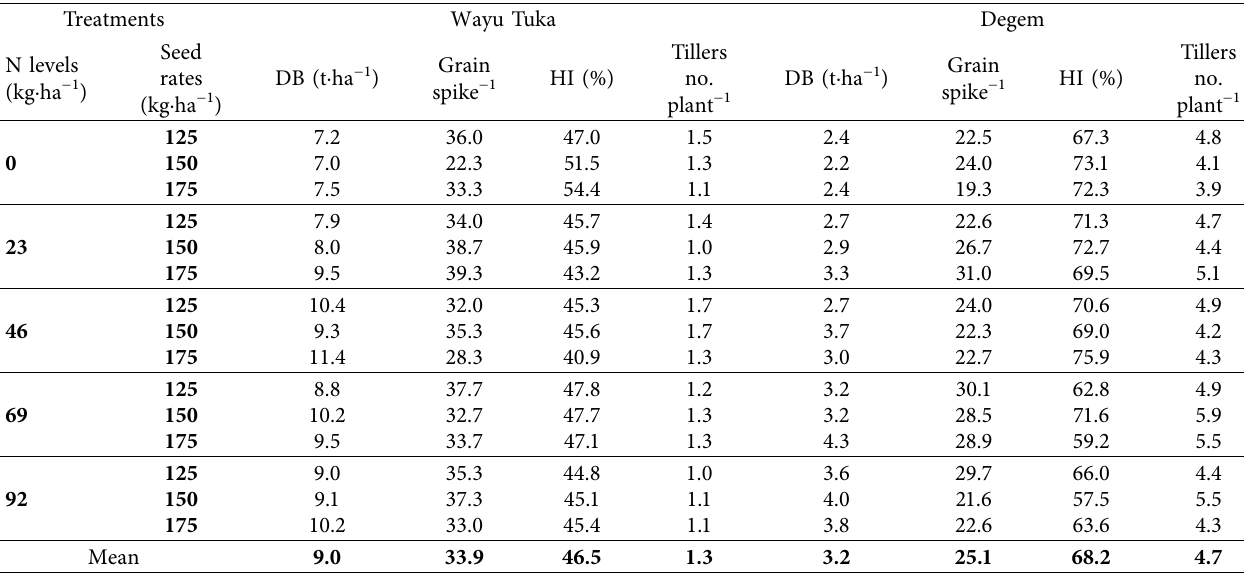
Bold values are the mean for diferent parameters across the